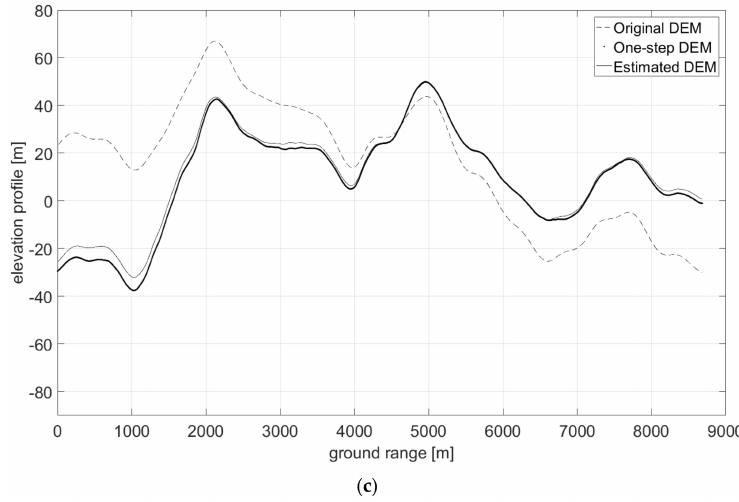
Figure 14. Comparison of original and estimated range profiles assuming known starting points: